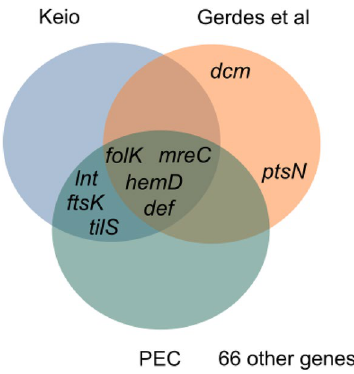
Figure 3. Venn diagram of the essentiality of the positively selected genes based on Keio, Pec, or Gerdes et al. datasets. Nine out of the 75 genes are essential according to at least one of three datasets.